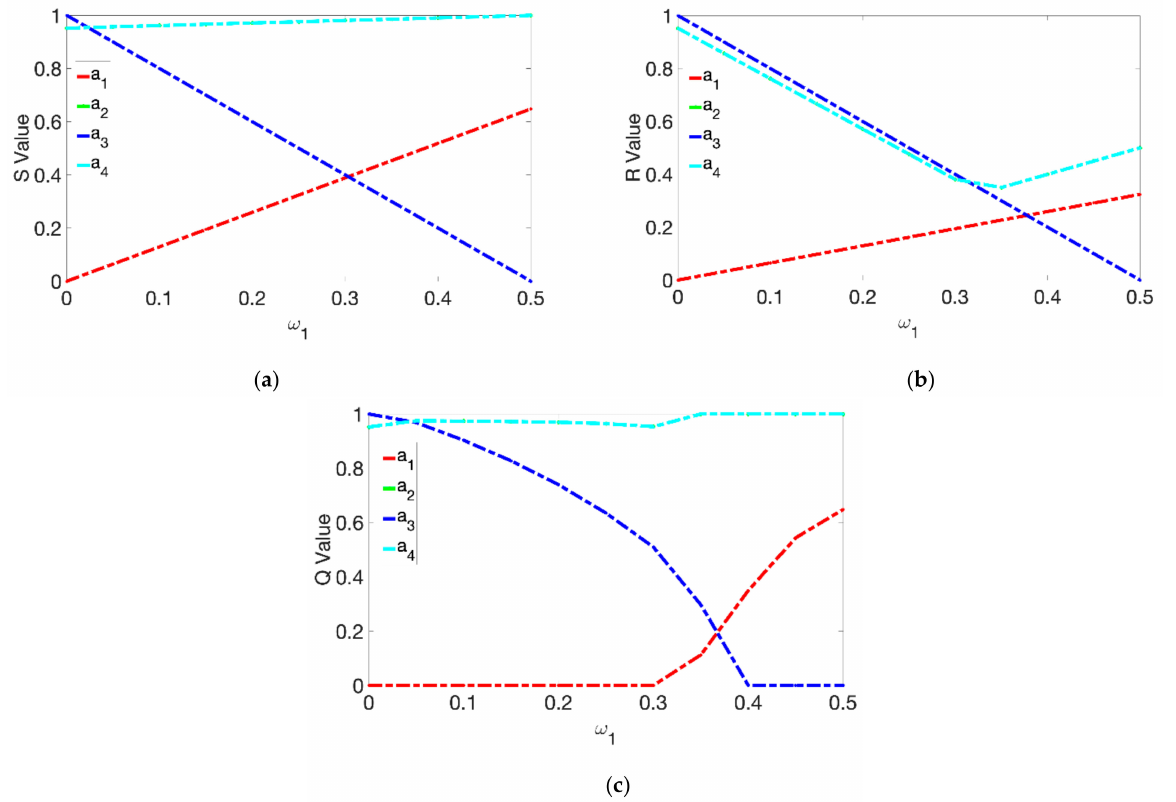
Figure 3. The impact of criteria weights. ( a ) The impact of criteria weights on the S i value of each expropriator’s scheme; ( b ) The impact of criteria weights on the R i value of each expropriator’s scheme; ( c ) The impact of criteria weights on the Q i value of each expropriator’s